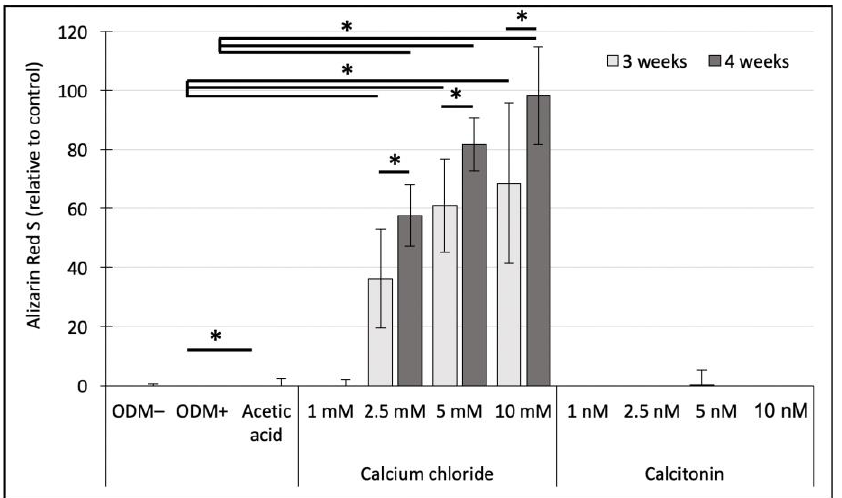
Figure 4. Photometric quantification of alizarin red S concentrations in human SaOs-2 cells. Cells were incubated with increasing concentrations of calcium chloride (1, 2.5, 5, and 10 mM) or calcitonin (1, 2.5, 5, and 10 nM) for three or four weeks. Concentrations of alizarin red S are represented relative to the ODM+ reference after three weeks. Values represent means of three independent assays in triplicate (n = 9) except for the ODM+ reference (n = 12), the negative control (ODM − ; n = 6) and the acetic acid control (n = 6) ± standard deviation. ODM; osteoblast differentiation medium. * Indicates a significant difference ( p < 0.05).